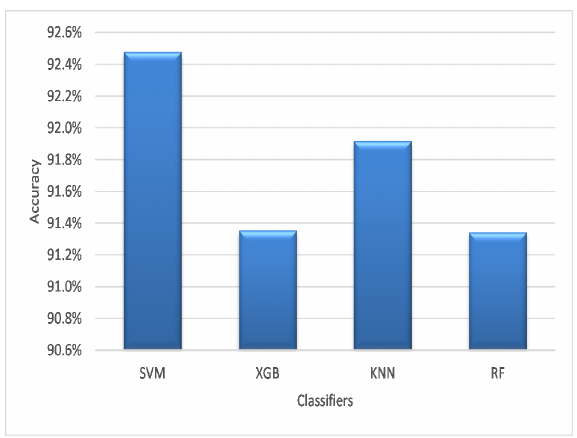
Figure 5. Average accuracy on the four classifiers.